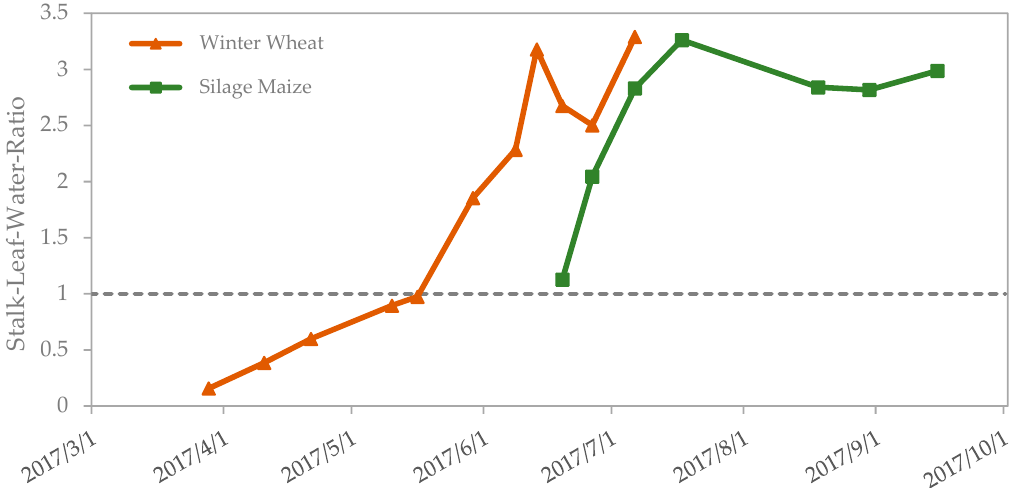
Figure 14. Ratio between water in the stalks compared with water in the leaves for winter wheat (orange) and maize (green). Water content is standardized to water loss per fresh mass. The grey line illustrates the 1:1 ratio between phyto-elements. Data was recorded at the 2017 MNI campaign.